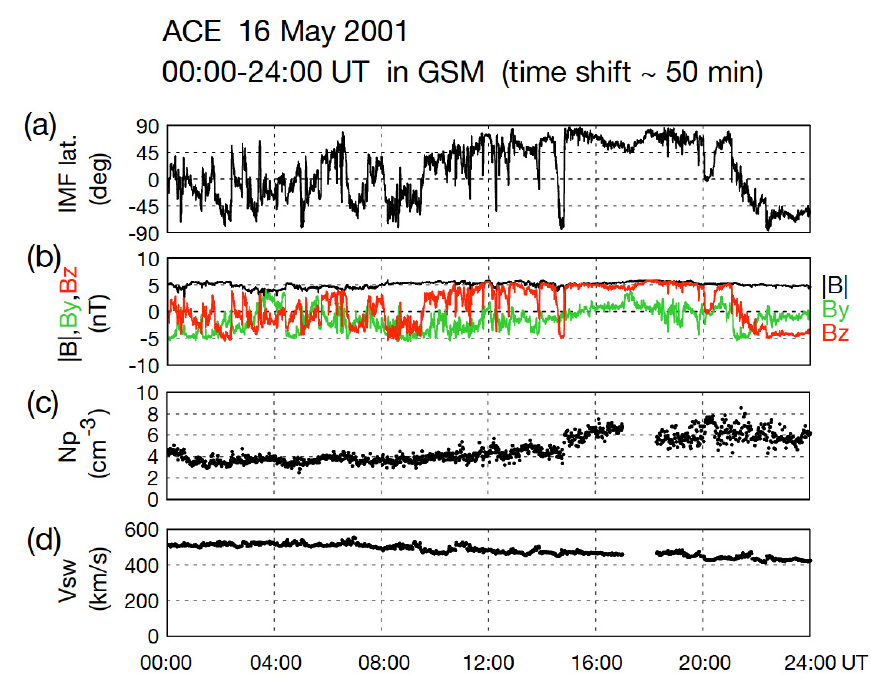
Fig. 2. ACE observation of the solar wind between 00:00–24:00UT on 16 May 2001, including a time shift of 50min from the ACE location to the Earth’s magnetosphere. From the top, (a) latitudinal angle of the IMF ( θ IMF ), (b) strength and Z component of the magnetic field, (c) proton density, and (d) bulk flow speed are